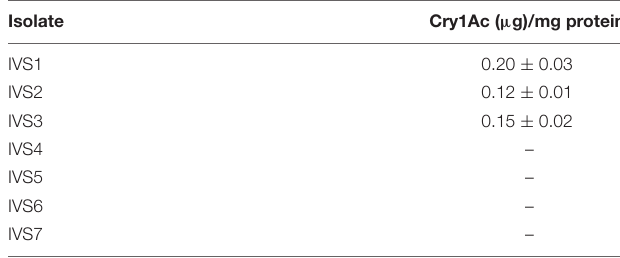
TABLE 2 | Quantification of active toxin produced from pro-Cry1Ac by gut bacterial proteases.